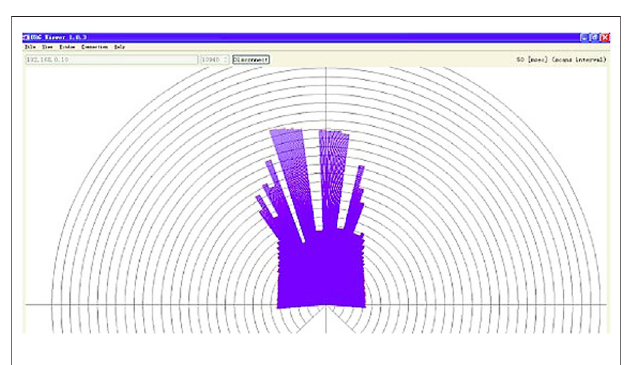
FIGURE 4 | Pre-processed